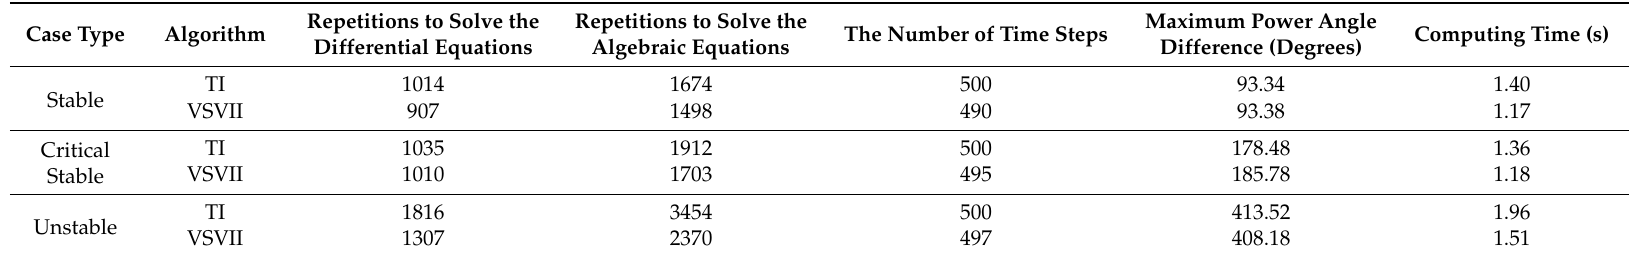
Table 2. Simulation results for a regional power system in